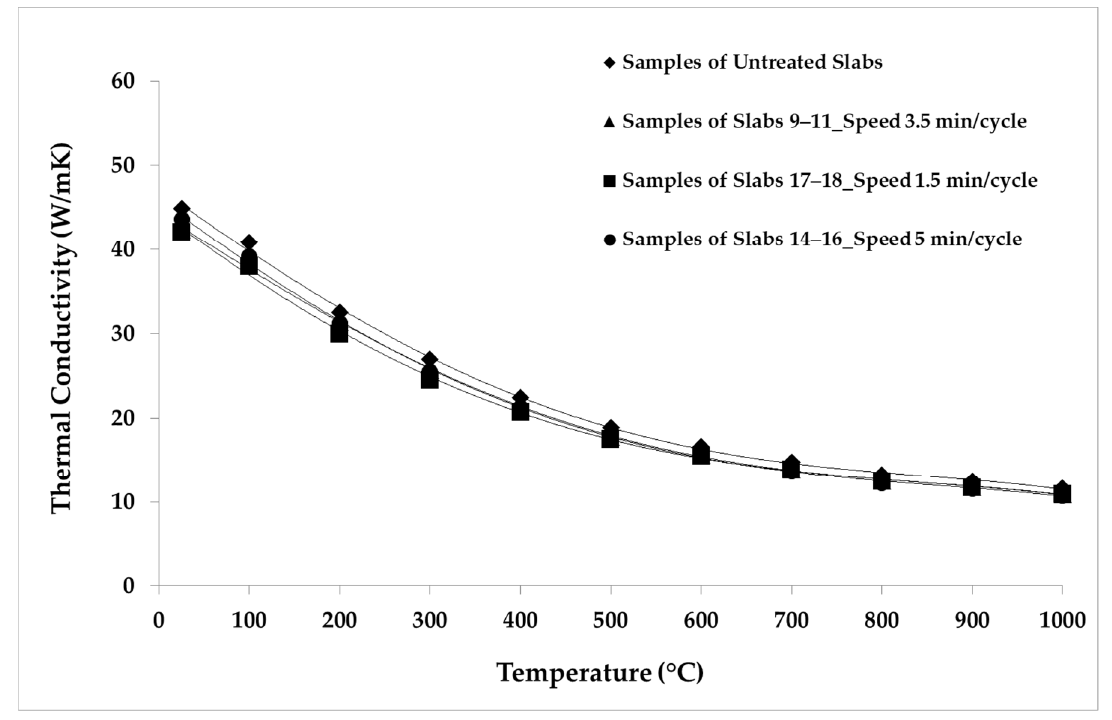
Materials 2021 , 14 , x FOR PEER REVIEW Figure 10. Thermal conductivity average values considering different speed of thermal cycles.